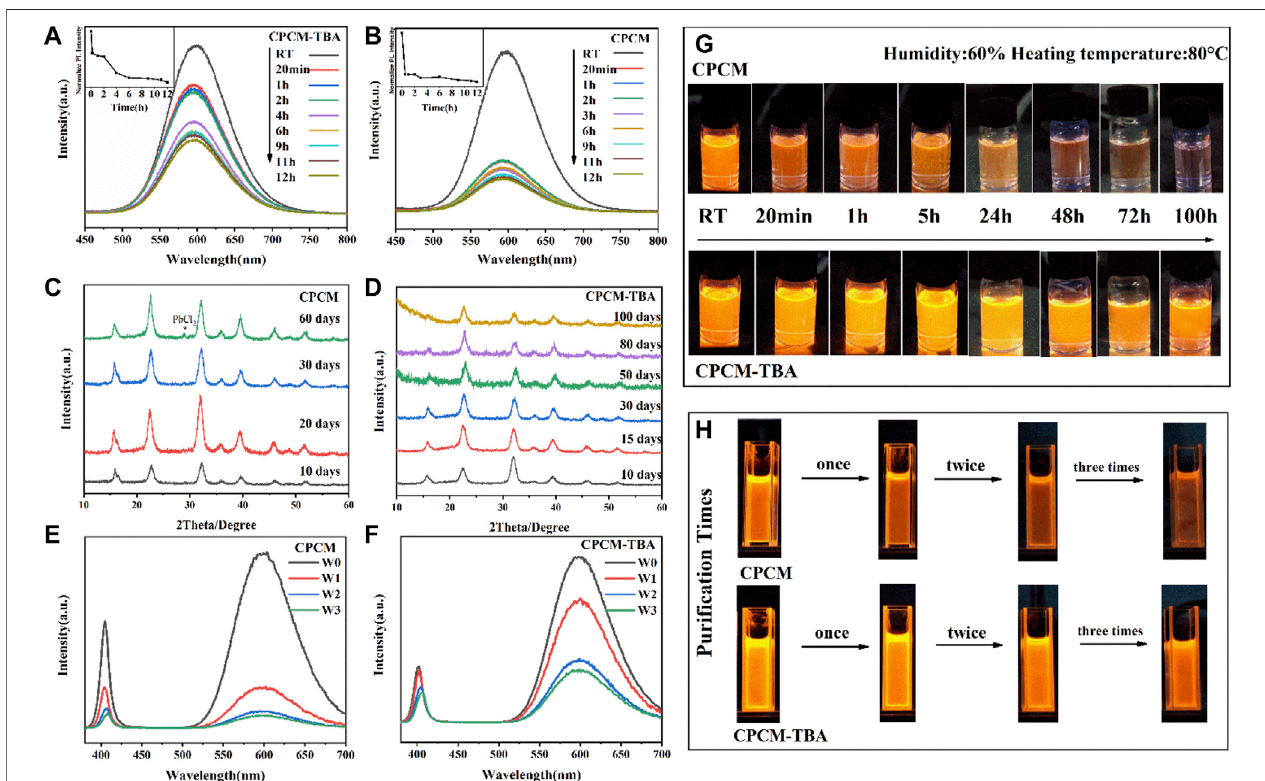
FIGURE 4 | PL spectra of CPCM (A) and CPCM-TBA (B) NCs and corresponding photos (G) at different time intervals under heating conditions. XRD patterns of CPCM (C) andCPCM-TBA (D) NCsatdifferenttimeintervals.PLspectraofCPCM (E) andCPCM-TBA (F) NCsandcorrespondingphotos (H) afterzero(W0),one(W1), two (W2), and three (W3) puri fi cation times. All photos were recorded under 365 nm